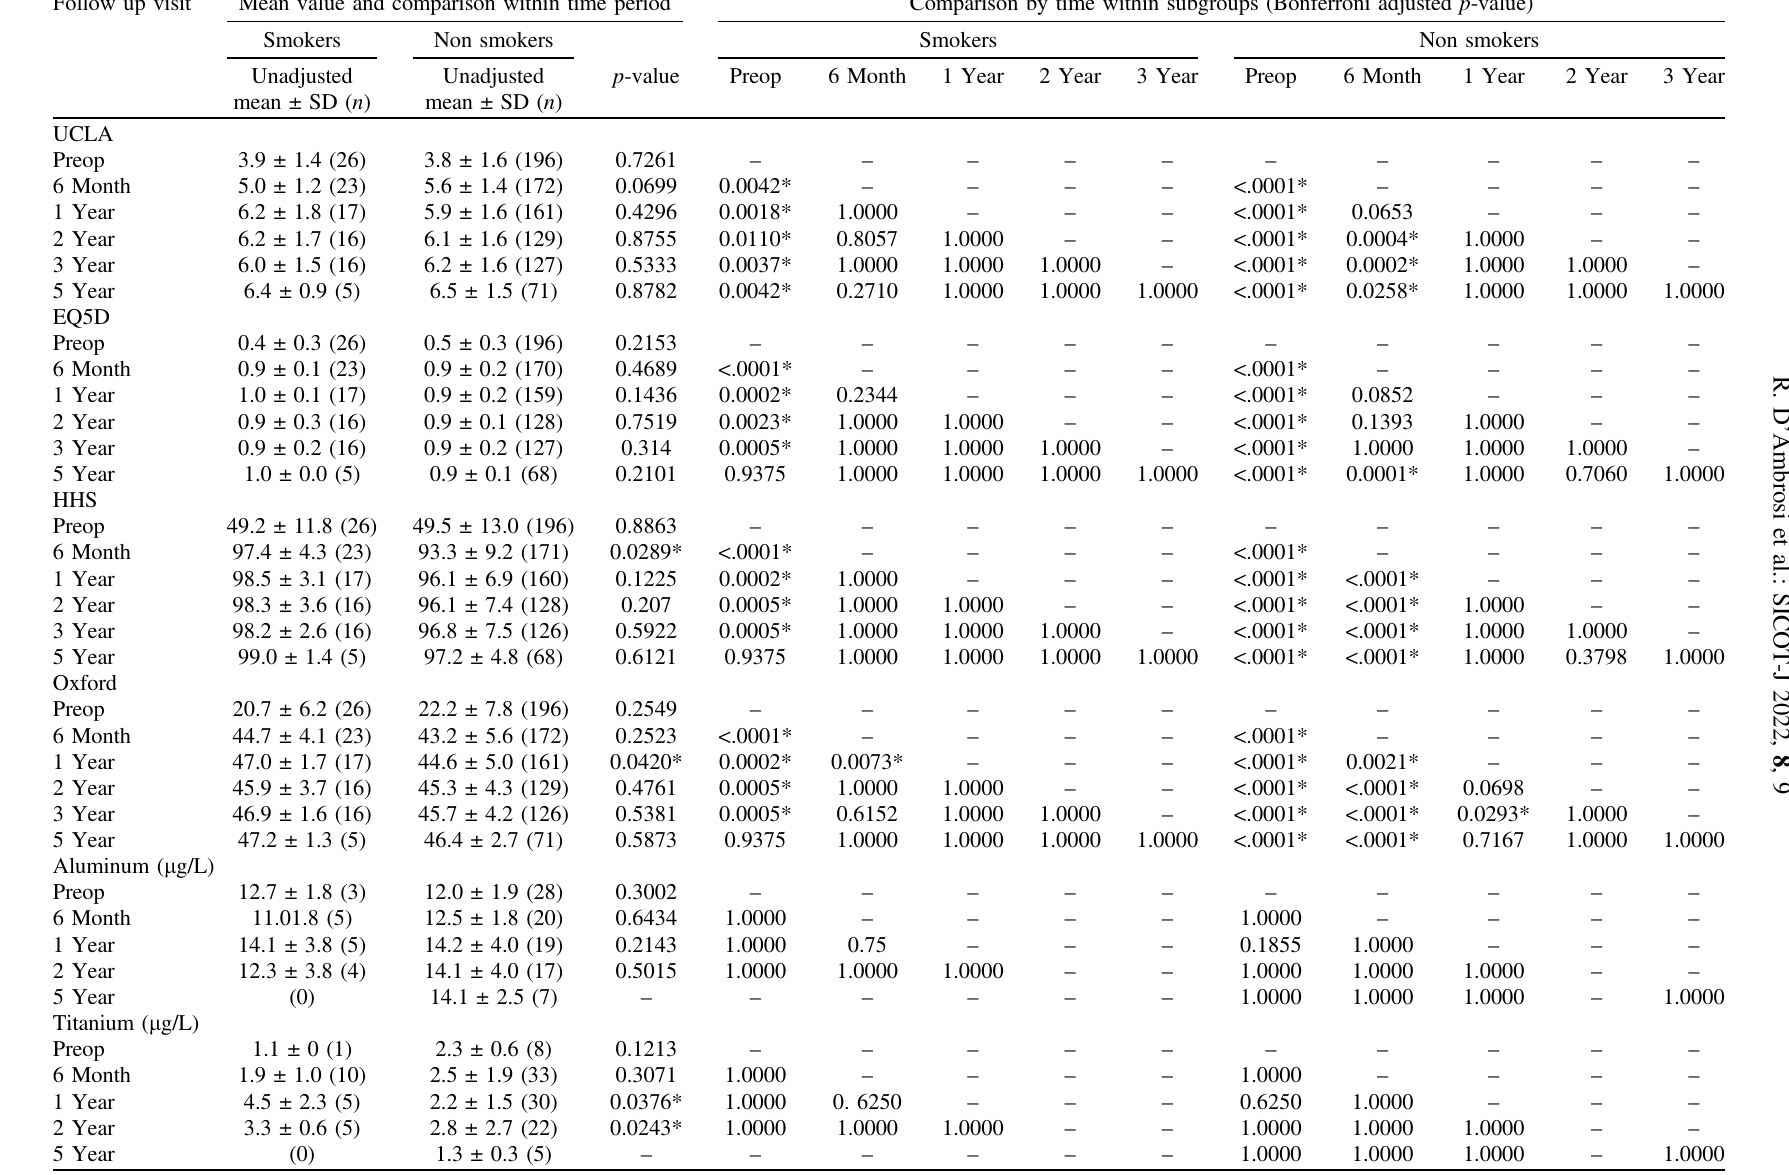
Table A.8. Subgroup analysis by tobacco